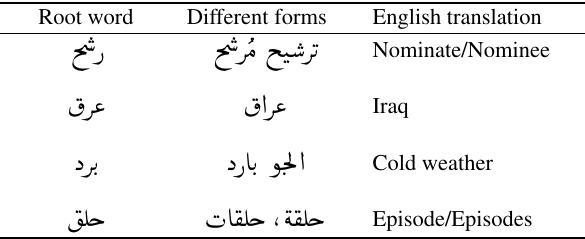
Table 7 Arabic words with multiple meanings based on